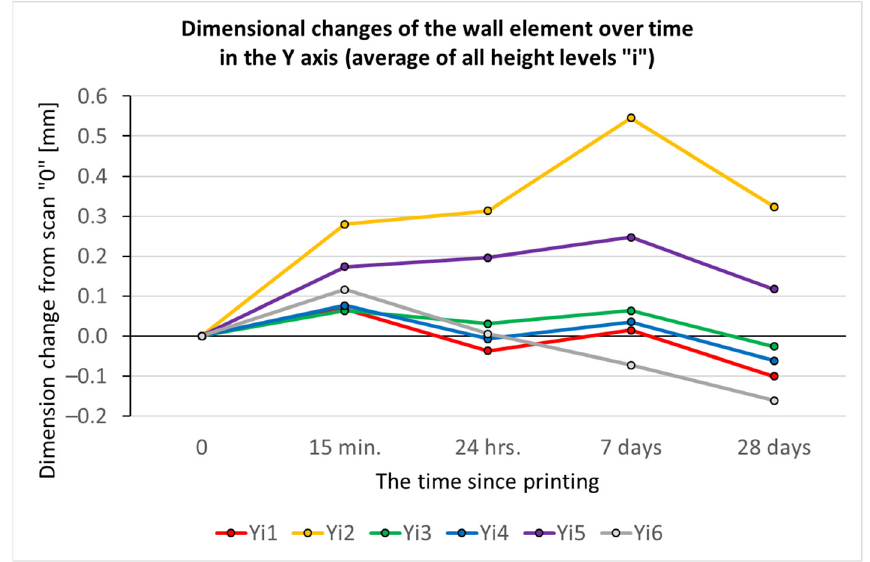
Figure 15. Dimensional changes of the wall element over time in the Y ‐ axis in individual vertical sections (based on local Caliper measurements).